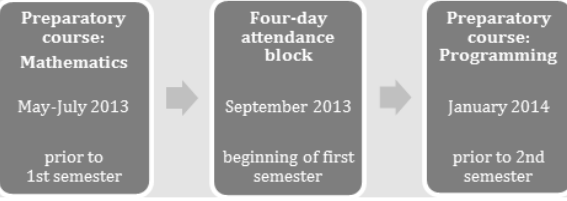
Figure 1. Courses during the initial phase